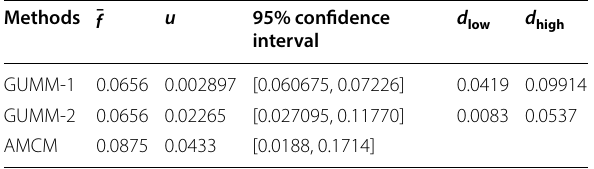
Table 6 Uncertainty evaluation results in experiment 1